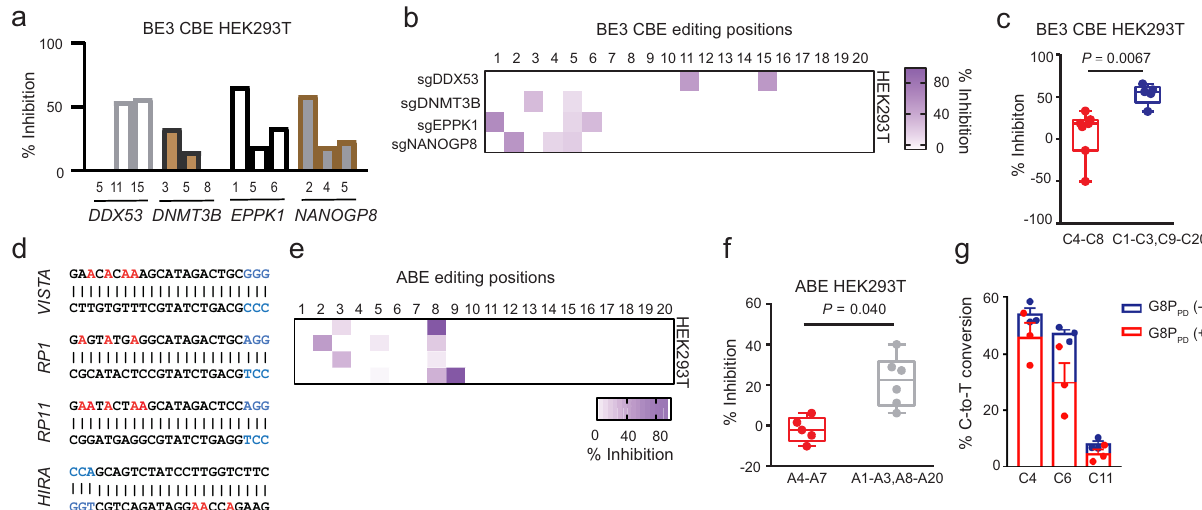
Fig. 3 The inhibitory activities of f1 G8PPD toward BE3 CBE and ABE7.10 at the endogenous genomic sites in human cell lines. a The inhibitory activity of f1 G8P PD toward BE3 CBE in HEK293T cells. b Heat map showing position-dependent inhibition of BE3 CBE by G8P PD. c Comparison of the inhibition rates of G8P PD at the on-target and out-of-window editing positions of BE3 CBE. For a – c , DDX53 , DNMT3B and EPPK1 groups contain 2 biologically independent replicates and NANOGP8 groups contain 3 biologically replicates. d Design of sgRNA for ABE7.10 targeted genomic loci. The PAM sequence and adenine positions are highlighted in blue and red, respectively. e Heat map showing the position-dependent inhibition of ABE7.10 by G8P PD . f Comparison of the inhibition rates of G8P PD at the on-target and out-of-window editing positions of ABE7.10. For c and f , the center line in each box indicates the median. The lower and upper bounds of each box represent the fi rst quartile (25%) and the third quartile (75%), respectively. The bottom and top of whiskers denote the minimum and maximum, respectively. Signi fi cant difference is determined using two-tailed Student ’ s t test. n.s., not signi fi cant. g Analysis of the effects of G8P PD on A3A CBE targeting at the ABE7.10 targeting site VISTA . The data are shown as mean ± SEM. For e – g , each sgRNA contains 3 biologically independent replicates. Source data are provided as a Source Data fi